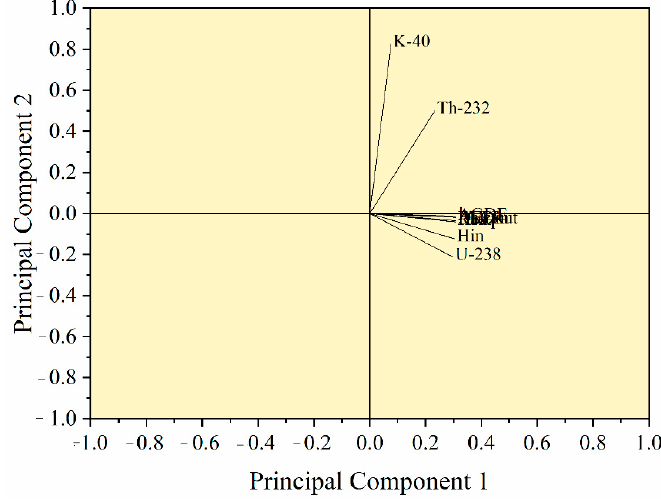
Figure 8. Principal component analysis (PC1 and PC2) for the radiological data.(the overlapping